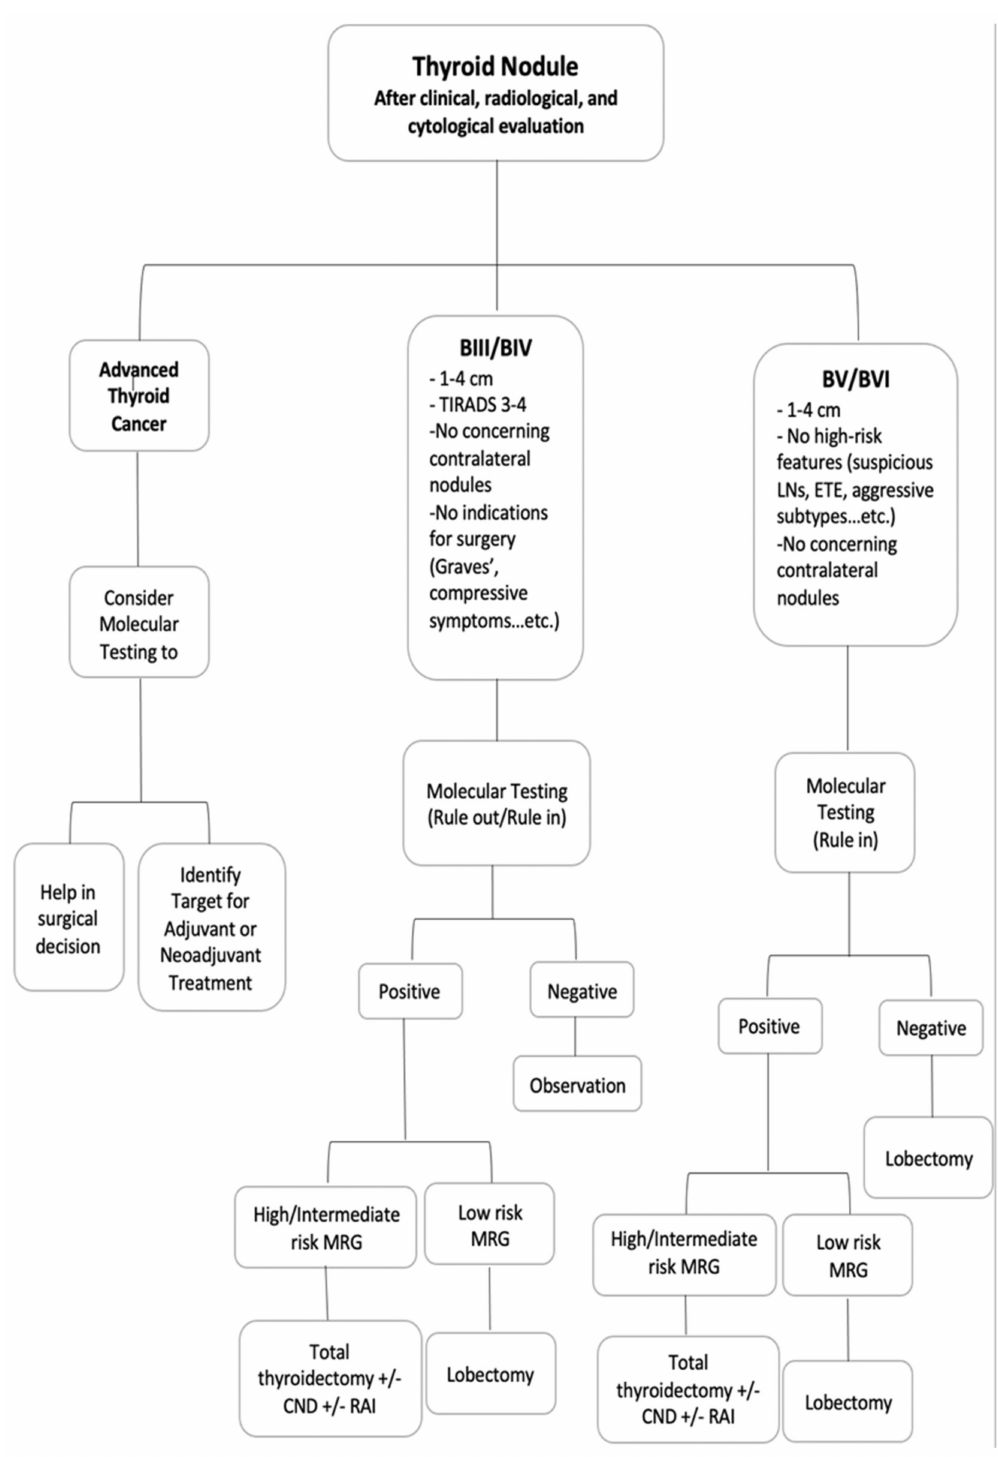
Figure 2. Our group algorithm for using molecular testing in thyroid nodules. Abbreviations: BIII: Bethesda III; BIV: Bethesda IV; BV: Bethesda V; BVI: Bethesda VI; MRG: molecular risk groups; CND: Central neck dissection; RAI: Radioactive Iodine